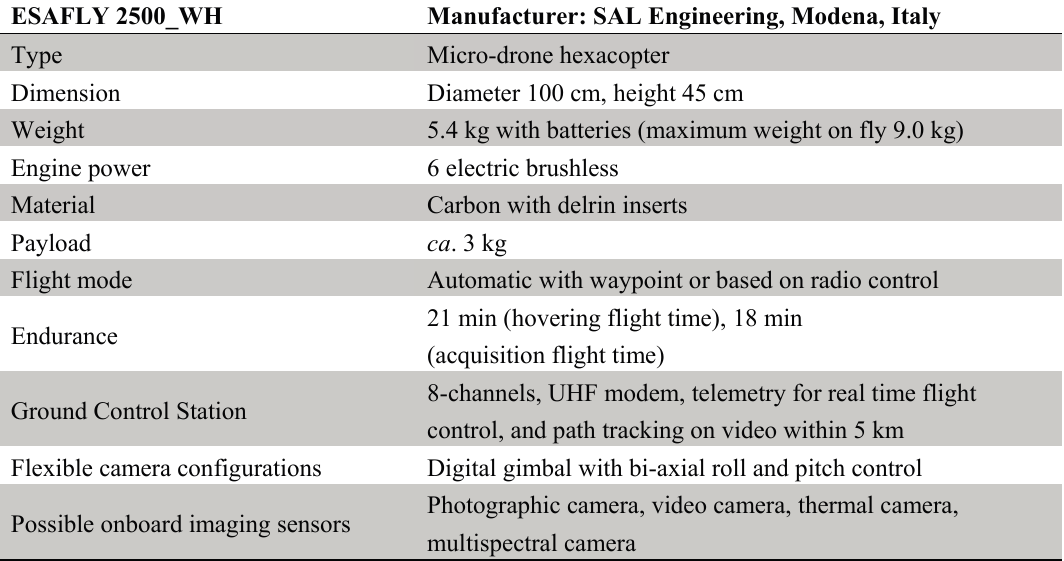
Figure 2. UAV hexacopter ESAFLY 2500_WH. Table 3. UAV specifications